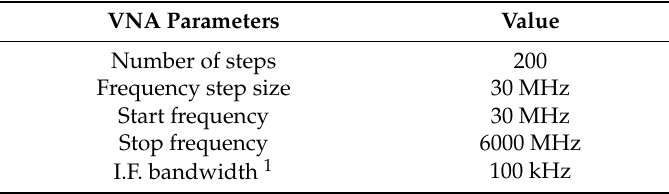
Table 5. Summary of the key VNA parameters used in field testing.